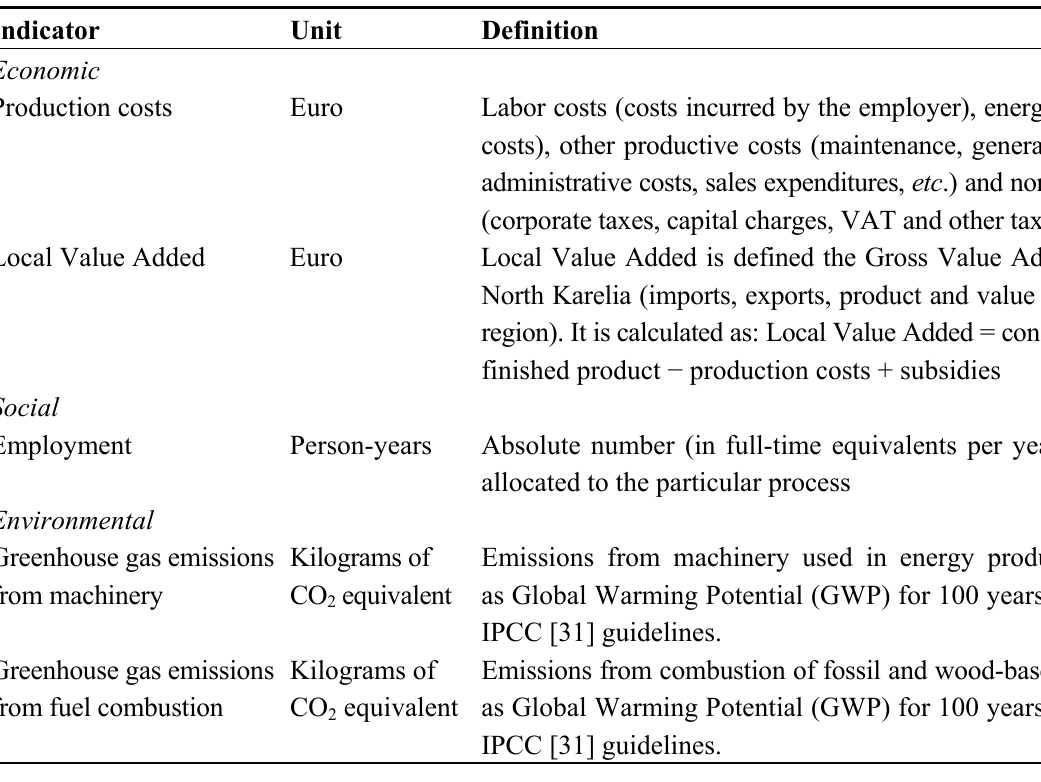
Table 3. Indicators used in the study, their units and